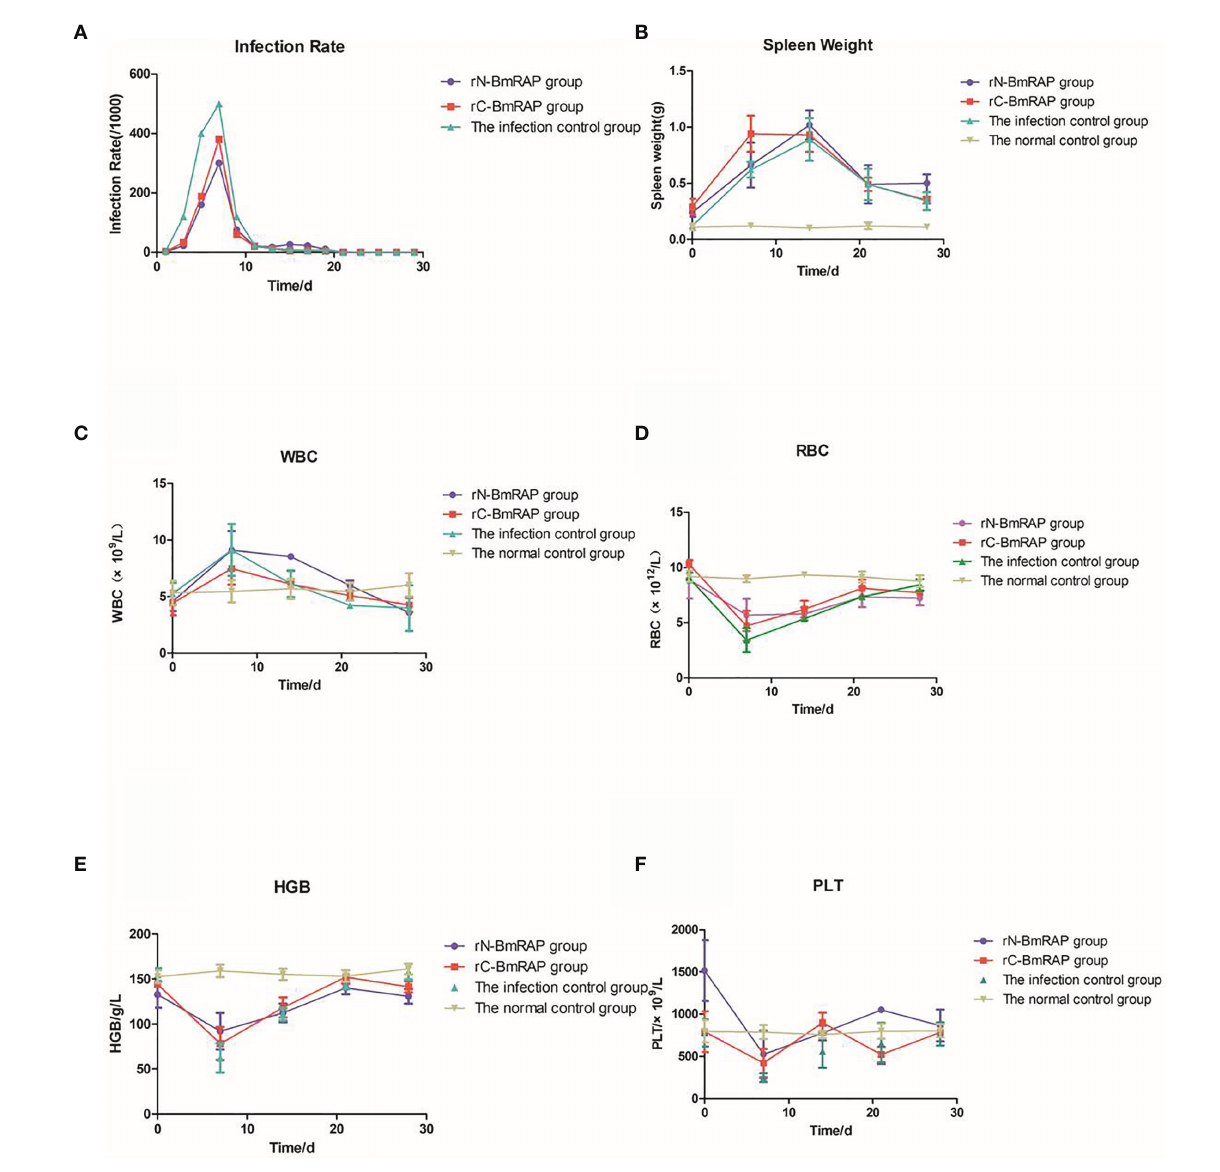
FIGURE 5 | In vivo immune protective effect of rBmRON2 proteins in B. microti infected mice. (A) Infection rates; (B) Changes in spleen weight; (C) White blood cell (WBC) counts; (D) Red blood cells (RBC) numbers; (E) Hemoglobin (HGB) content; (F) Platelet (PLT) numbers. Normal (uninfected) control group (yellow line, inverted triangles); Infected control group (green line, triangles), rC-BmRON2 group (red line, squares), rN-BmRON2 group (purple line,